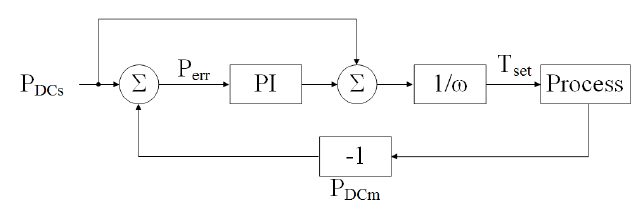
Fig. 8. Block schematic of the motor drive system’s power flow control loop.